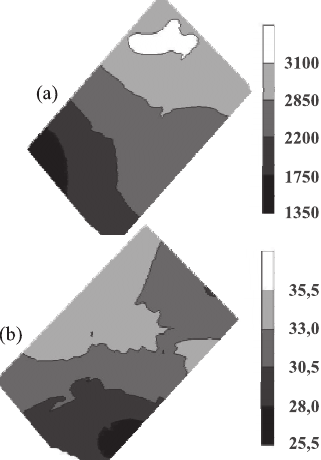
Figura 2. Mapas de krigagem para (a) rp máxima [kpa] e (b) profundidade da rp máxima